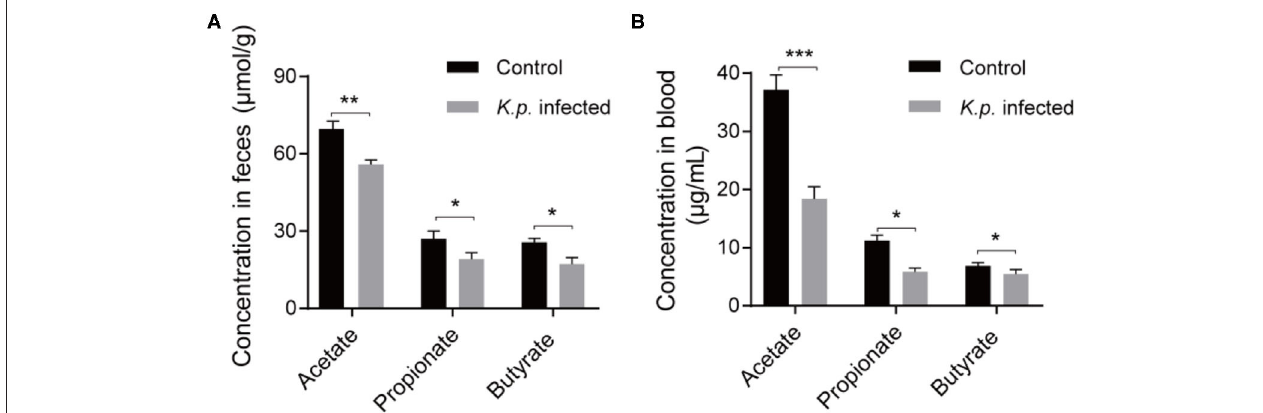
FIGURE 4 | Detection of absolute concentration of SCFAs in Klebsiella pneumoniae mice and healthy controls. (A) The absolute concentration of SCFAs in cecal contents from K. pneumoniae -infected mice and controls. (B) The absolute concentration of SCFAs in serum from K. pneumoniae -infected mice and controls. Data are from one experiment representative of three independent experiments (mean ± s.e.m). Group size is 8–12 per group. P- values are determined using two-tailed Student’s t -tests (A,B) . * P < 0.05, ** P < 0.01, *** P <